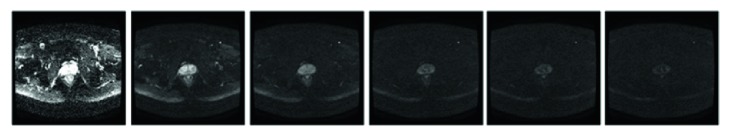
DWI acquired by b = 0, 500, 800, 1200, 1500, and 2000 s/mm2 shows the tendency of intensity changes.